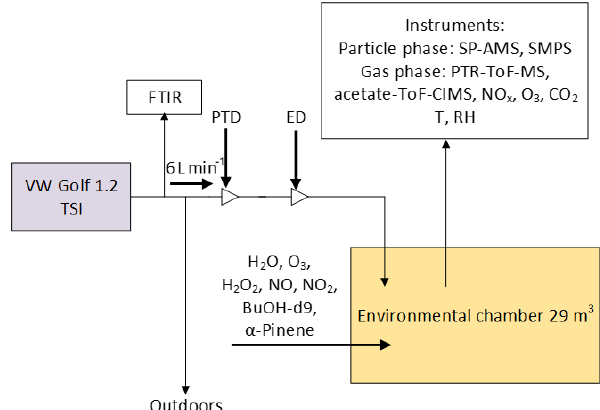
Figure 1. Schematic (not to scale) of the experiment setup. The ve- hicle was driven at constant load of 80kmh − 1 for different periods of time during the feeding period on a chassis-type dynamometer. Emissions were sampled at 6Lmin − 1 through a heated dilution and sampling system using two stage dilution systems, including porous tube diluter (PTD) and ejector diluter (ED), into ILMARI environ- mental chamber (Leskinen et al., 2015). The raw exhaust was sam- pled with the